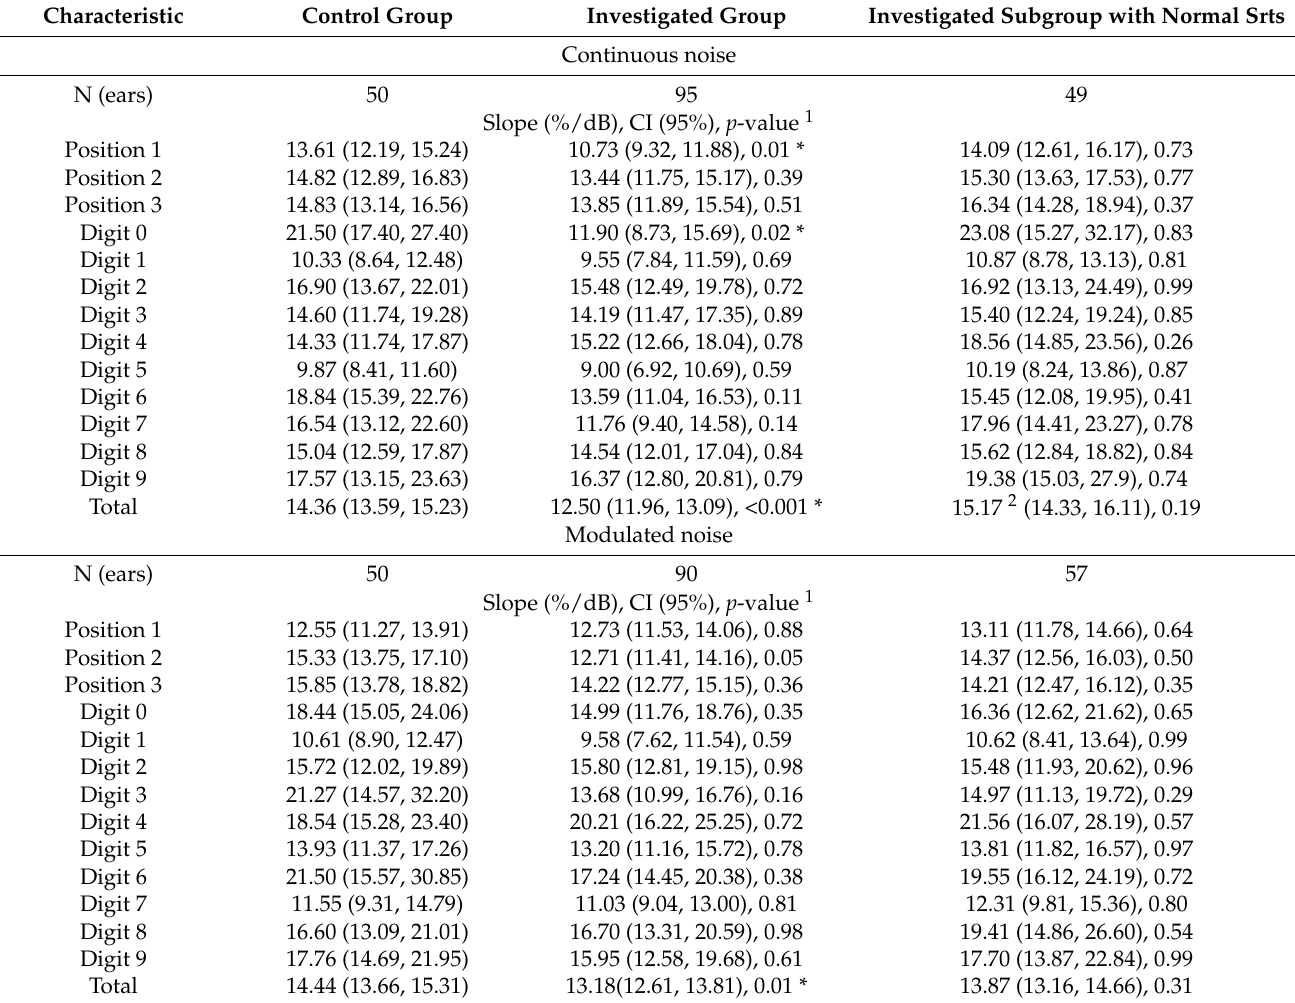
Table A2. Position-specific and digit-specific slopes of the psychometric